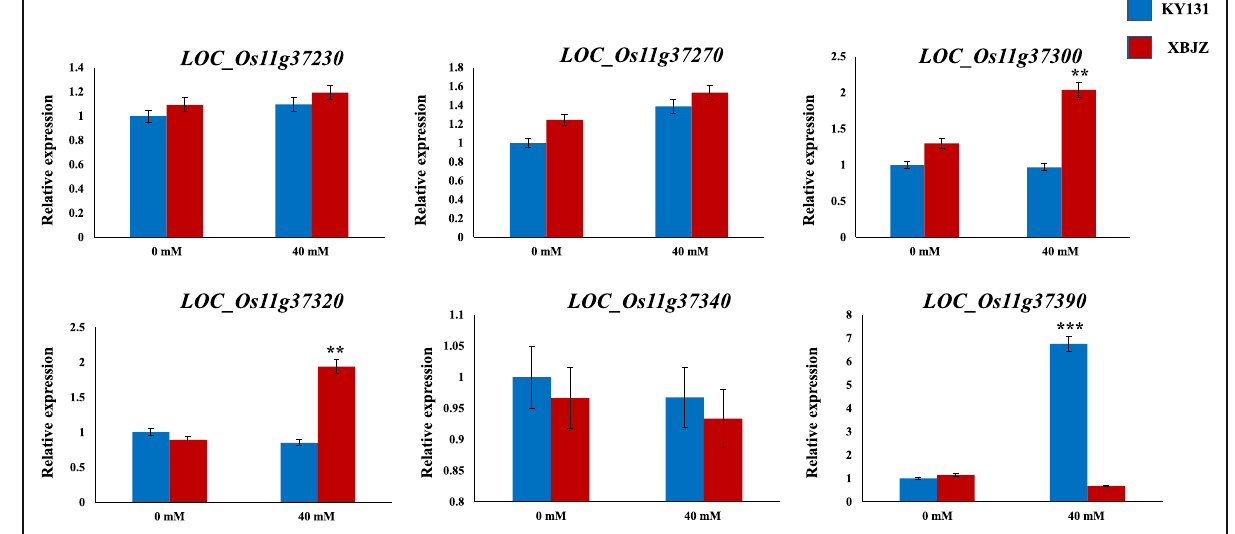
Fig. 5 Expression patterns of six genes under normal growth conditions and alkali stress (** P < 0.01; *** P < 0.001; Student ’ s t -test)